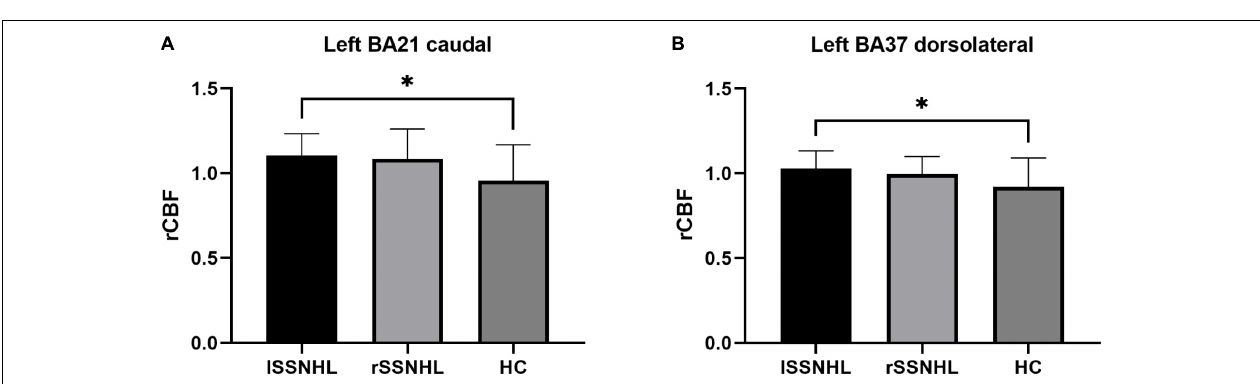
FIGURE 6 | Comparisons of auditory ROIs rCBF values among the three groups (lSSNHL, rSSNHL and HCs). lSSNHL showed increased rCBF in auditory-related areas (A) left BA21 caudal ( p = 0.02) and (B) left BA37 dorsolateral ( p = 0.047) compared to HC. ∗ p <